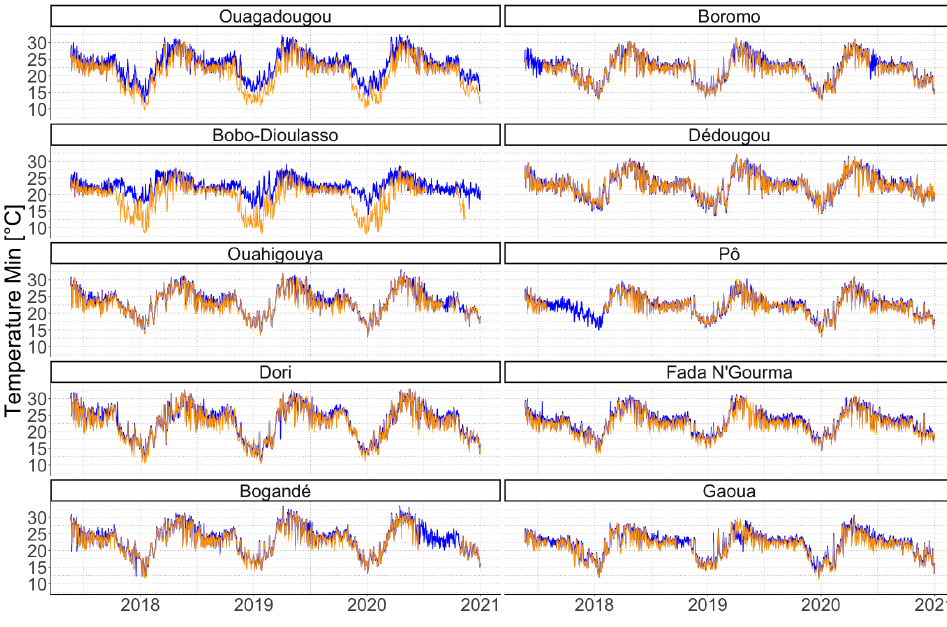
Figure 7. Comparison of minimum temperature time series between TAHMO stations (in orange) and the corresponding stations from meteorological service of Burkina Faso (in blue).